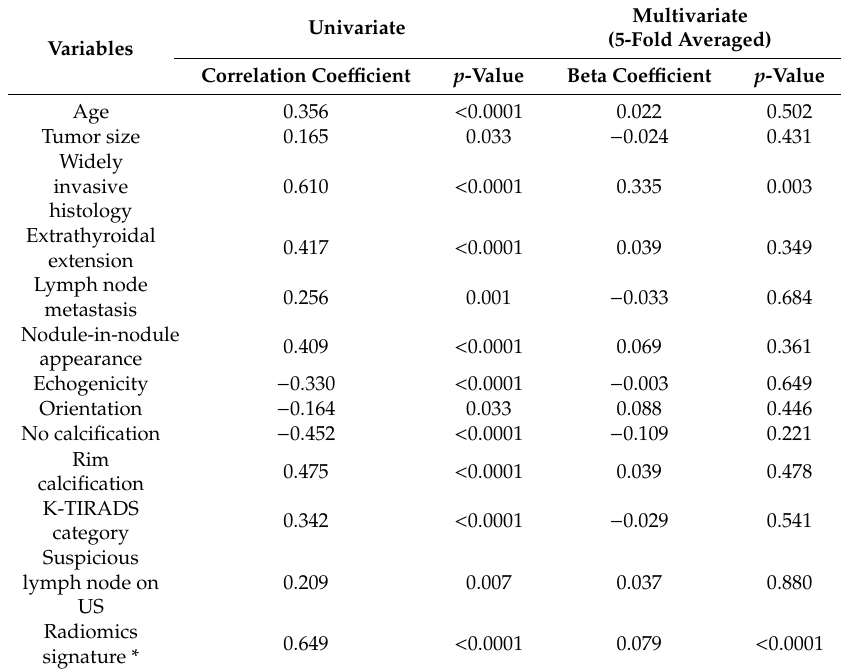
Table 4. Univariate correlation and multivariate logistic regression analysis associated with distant metastases of